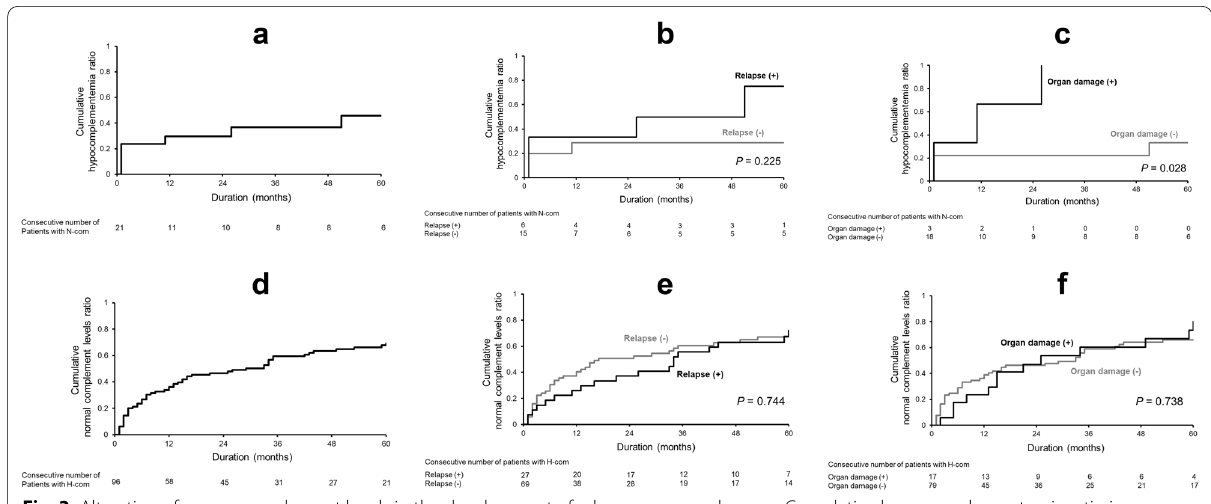
Fig. 3 Alteration of serum complement levels in the development of relapse or organ damage. Cumulative hypocomplementemia ratio in patients with normal serum levels of C3, C4, and CH50 (N-com) ( a ). Survival curves in patients with N-com determined by the Kaplan–Meier and log-rank tests showing cumulative hypocomplementemia ratio between those with relapse (black line) and those without relapse (gray line) ( b ), and between those with organ damage (black line) and those without organ damage (gray line) ( c ). Cumulative normal complement levels ratio in patients with lower than normal serum levels of one or more complements in C3, C4, and/or CH50 (H-com) ( d ). Survival curves in patients with H-com determined by the Kaplan–Meier and log-rank tests showing cumulative normal complement levels ratio between those with relapse (black line) and those without relapse (gray line) ( e ), and between those with organ damage (black line) and those without organ damage (gray line) ( f